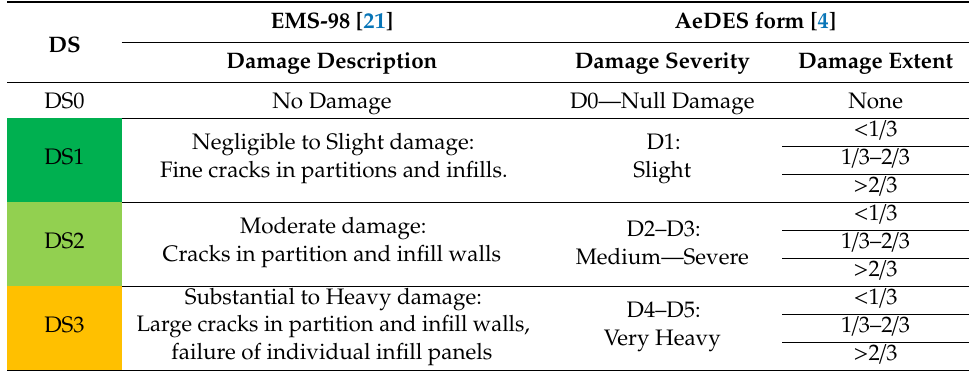
Table 1. Correspondence of damage level according to EMS-98 and AeDES form (each background color represents the related DS in the following